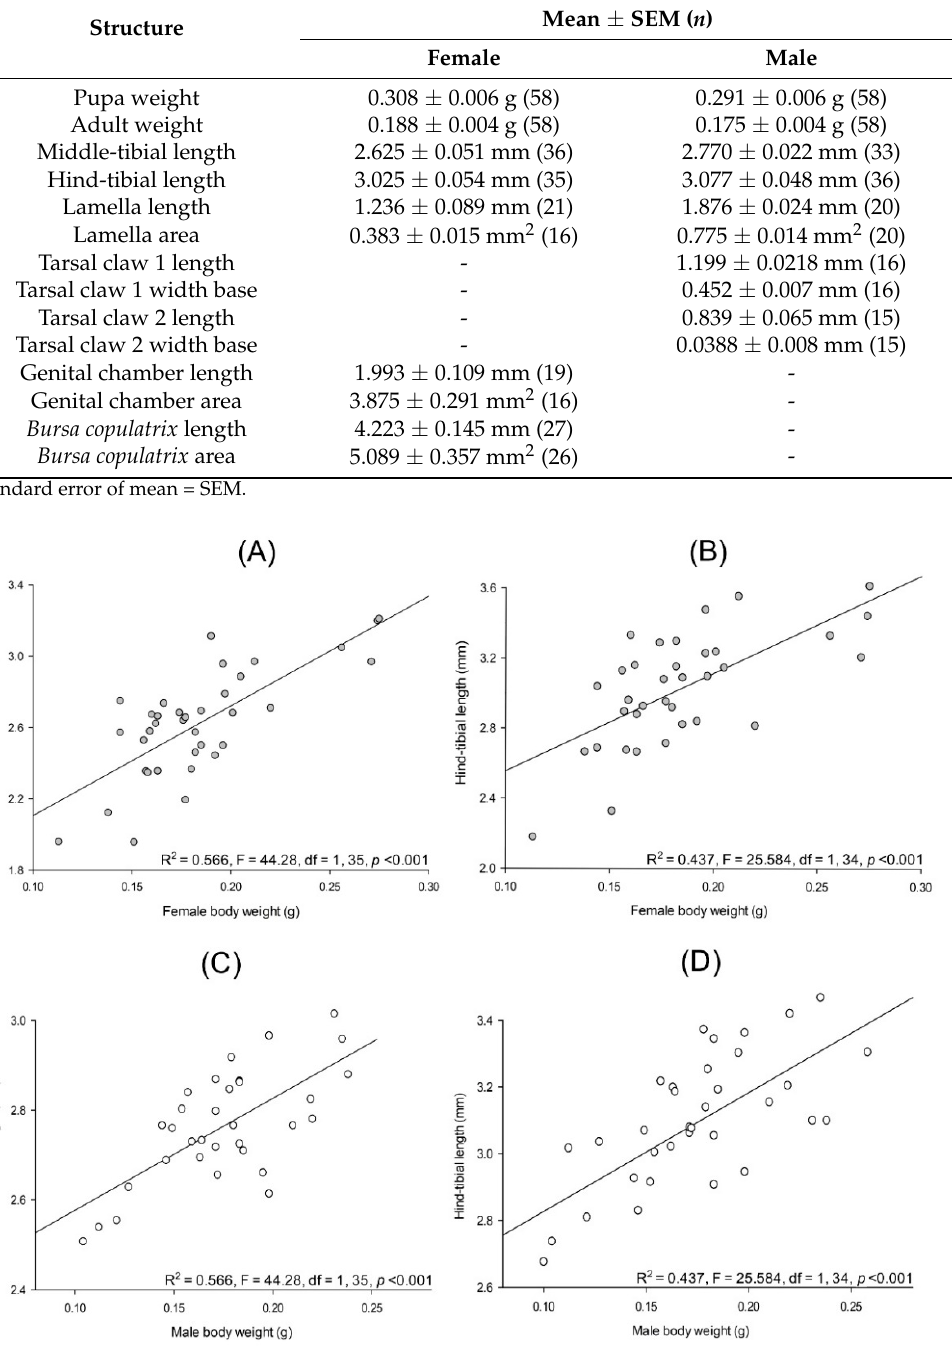
Figure 11. Relationships between body weight and tibial length on Cyclocephala barrerai . Female body weight and ( A ) middle-tibial length and ( B ) hind-tibial length; male body weight and ( C ) middle-tibial length and ( D ) hind-tibial length. Female = filled dots, male = open dots.